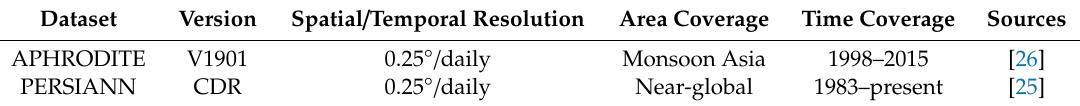
Table 1. Description of the gridded precipitation datasets used in this study. APHRODITE: Asian Precipitation-Highly Resolved Observational Data Integration towards Evaluation and PERSIANN-CDR: Precipitation Estimation from Remotely Sensed Information using Artificial Neural Networks-Climate Data